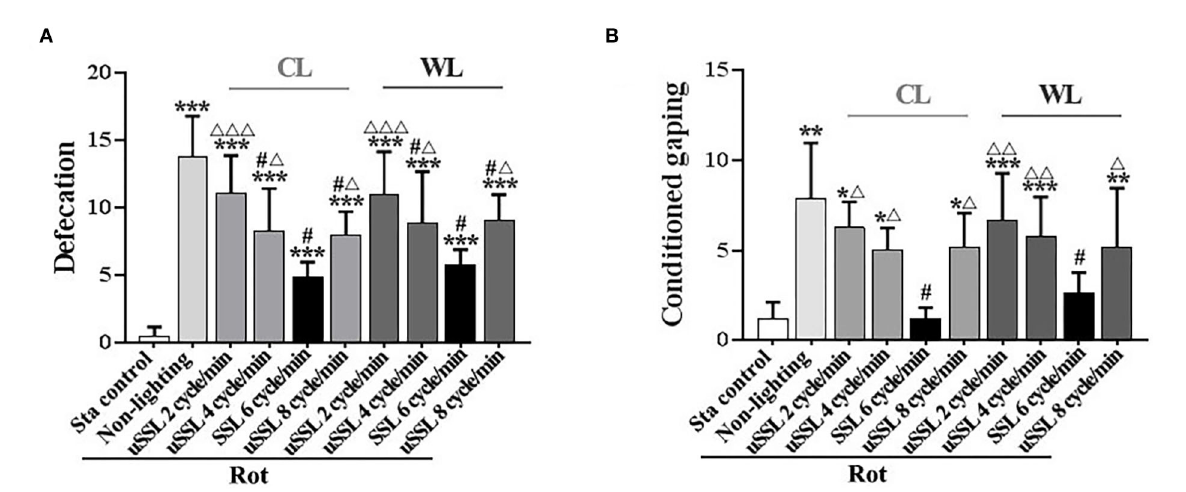
FIGURE2 Effects of synchronized (6 cycle/min) or unsynchronized stroboscopic light (2, 4, and 8 cycle/min) at 100Lm on defecation (A) and conditioned gaping (B) induced by rotation in rats. Rot, rotation stimulation; Sta, static control treatment; SSL, synchronized stroboscopic light; uSSL, unsynchronized stroboscopic light; CL, cool light; WL, warm light. Data are expressed as mean ± S.E. * P < 0.05, ** P < 0.01, *** P < 0.001 vs. the Sta control group; # P < 0.001 vs. the Rot non-lighting group; 1 P < 0.05, 11 P < 0.01, 111 P < 0.001 vs. the corresponding SSL (6 cycle/min) Rot group with the same color temperature.